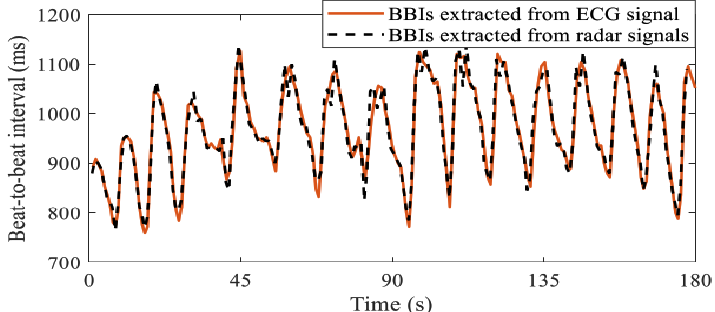
Figure 20. Beat-to-beat intervals (BBIs) obtained from one subject in comparison with an ECG reference [172].